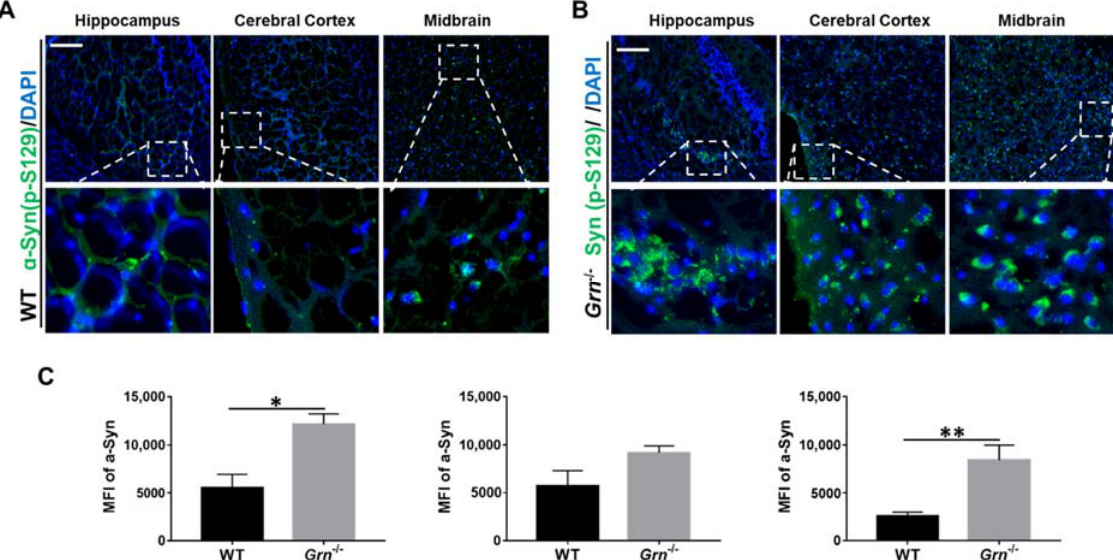
Figure 4. PGRN deficiency caused the accumulation of phosphorylated α -syn in aged mice. Frozen brain sections from 12-month-old WT and Grn − /– mice were stained with anti- α -syn antibody. Brain regions of hippocampus, cerebral cortex, and midbrain were analyzed. ( A , B ) Representative images of three different brain regions from three independent WT mice or Grn − / − mice. ( C ) The mean fluorescence intensity (MFI) of α‐ syn per section was quantified. Scale bar: 100 μ m. n = 3. Data presented as mean ± SD. * p < 0.05, ** p < 0.01.